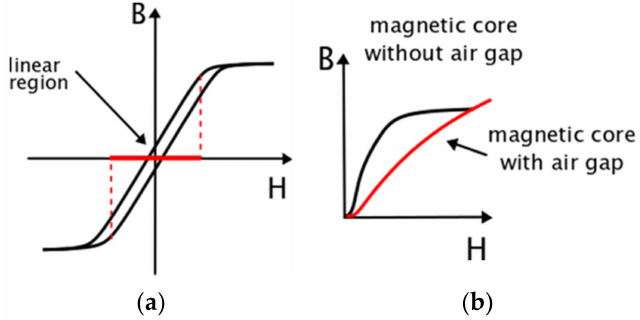
Figure 1. ( a ) Hysteresis loop; ( b ) theoretical nonlinear magnetization curves.